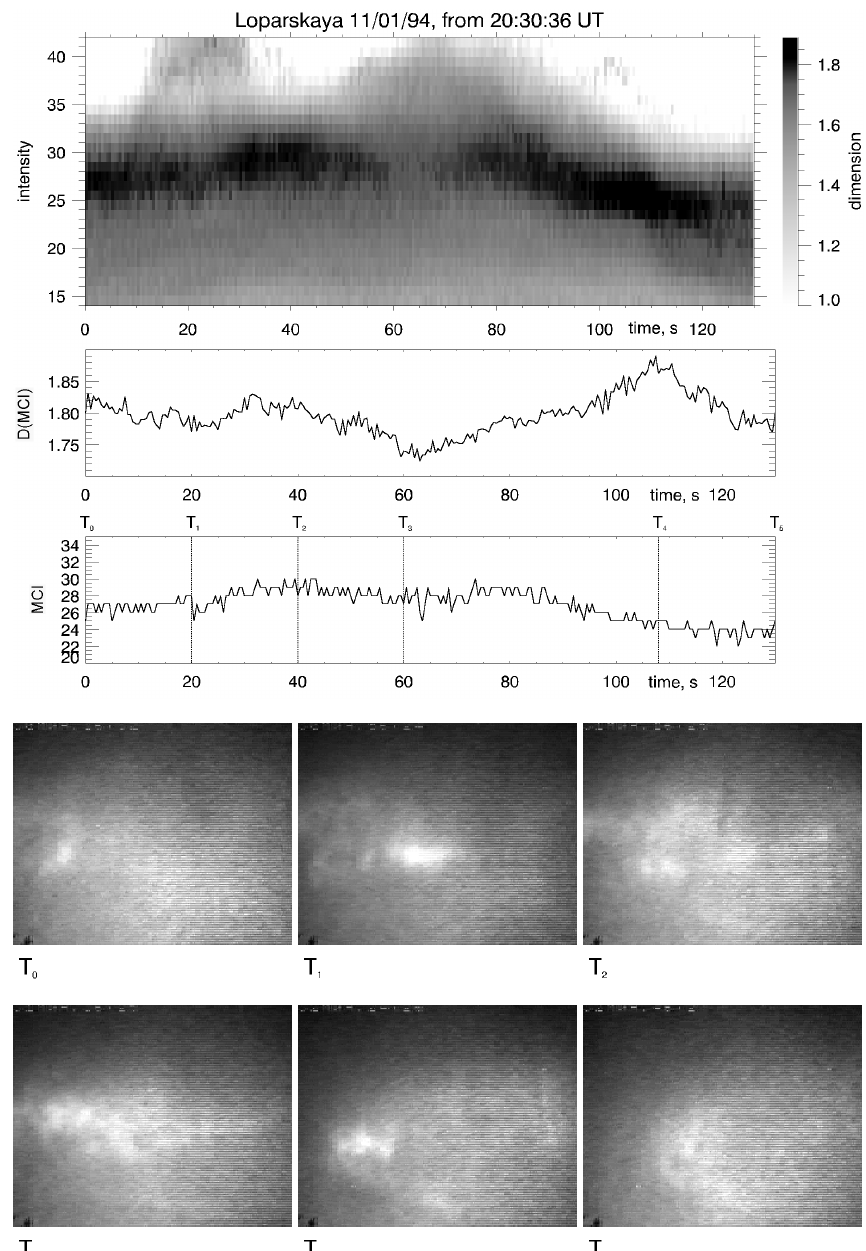
Fig. 10. The same as Fig. 9, but for event 2.